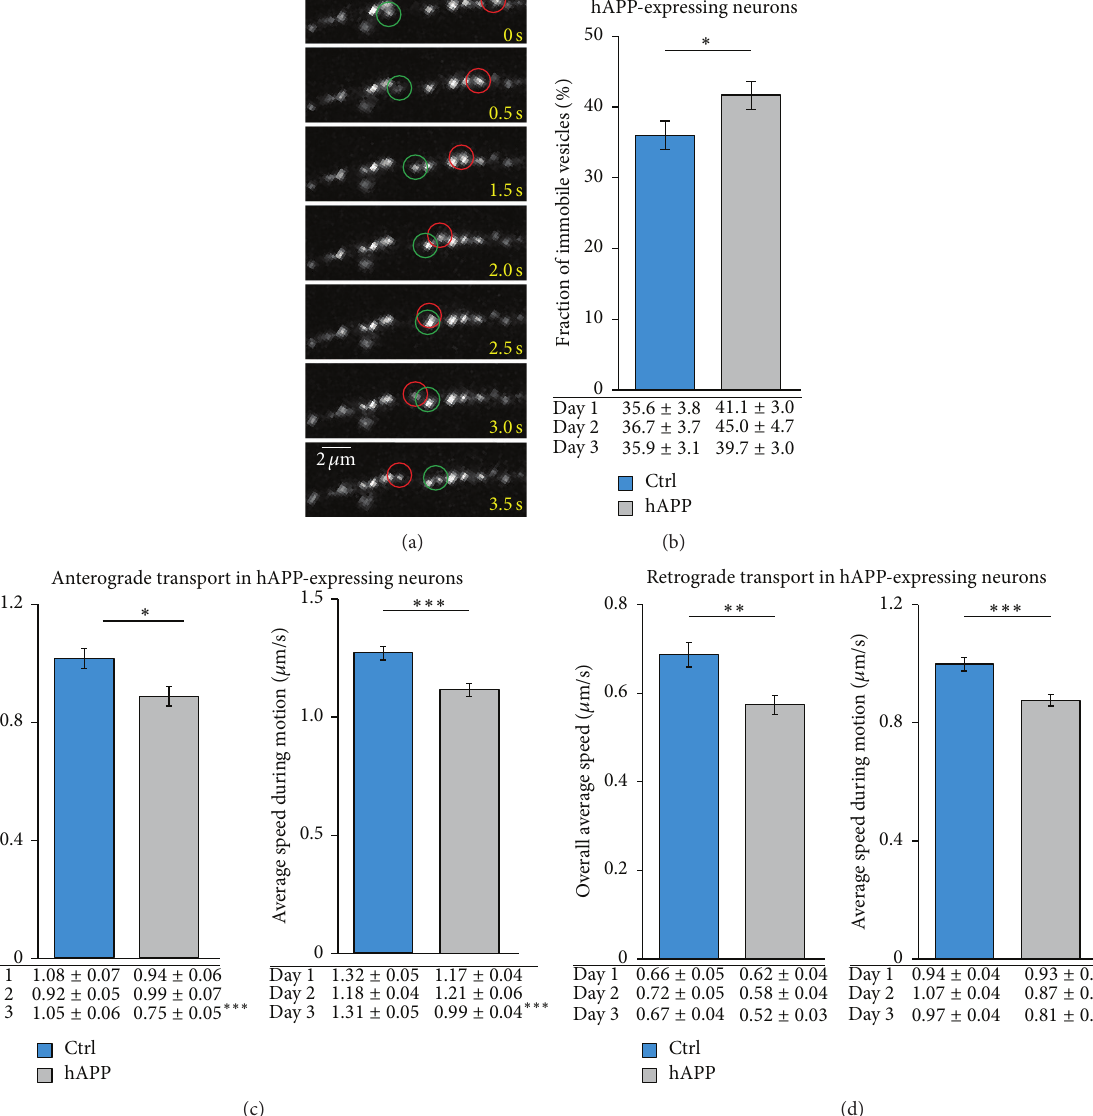
Figure 2: Expression of hAPP reduced vesicular transport of BDNF. Dissociated hippocampal neurons of C57BL/6 mice were cotransfected at 10 DIV with BDNF-mCherry and hAPP-YFP. The dynamic behavior of BDNF-containing vesicles was analyzed by live cell imaging 1–3 days after transfection. (a) Representative picture of BDNF-containing vesicles at different time points of time-lapse recording. Red and green circles mark BDNF-containing vesicles showing a directional movement. (c) Bar diagram indicates the mean percentage of immobile BDNF- containing vesicles in control neurons or in neurons transfected with hAPP during the whole observation period. Tables below bar diagram give the mean value of the incidence of immobile vesicles for day 1, day 2, and day 3. Transient expression of hAPP significantly changed the proportion of immobile vesicles. (d) Transport dynamics of anterogradely directed BDNF-containing vesicles. Bar diagrams show the mean value of the indicated motional properties during the whole observation period. Tables below bar diagrams give the mean value of the indicated motional property for day 1, day 2, and day 3. The overall average speed as well as the average speed during motion was significantly reduced in neurons transfected with hAPP compared to control neurons. While the characteristics of BDNF-containing vesicles were similar in neurons expressing hAPP and control neurons at day 1 after expression of hAPP, the average speed of BDNF-containing vesicles was significantly reduced in neuronal cultures transfected with hAPP at day 3. (e) Transport dynamics of retrogradely directed BDNF-containing vesicles. The motional properties as indicated were significantly changed in neurons transfected with hAPP compared to controls ( ∗ 𝑝 < 0.05 , ∗∗ 𝑝 < 0.01 , ∗∗∗ 𝑝 < 0.001 ; two-way ANOVA followed by pairwise multiple comparison). Error bars represent